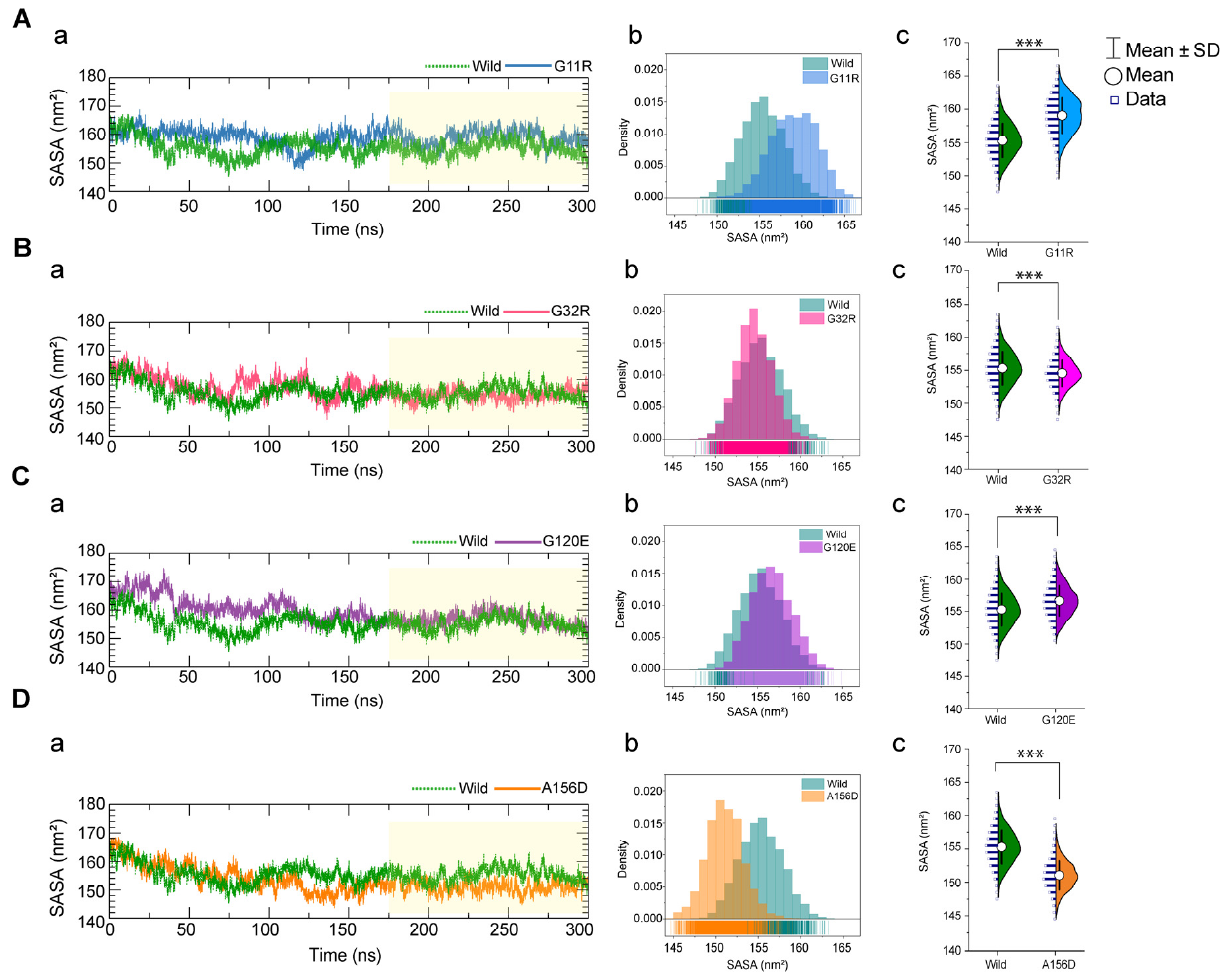
Figure 4. Analysis of total solvent accessible surface area (SASA) of the protein inferring the changes in the NAGK conformational stabilities. SASA value of G11R ( A ), G32R ( B ), G120E ( C ), and A156D ( D ) variants versus wild-type NAGK, where, in all cases, ( a ) represents time-dependent changes during the simulation, while ( b ) and ( c ) describe probability density and mean difference in the SASA distribution, based on the last 125 ns trajectories. The annotations used in A ( c ), B ( c ), C ( c ), and D ( c ) represent statistical significance, denoting *** p < 0.0001. Two-tailed, equal-sample variance Student’s t -tests were used to calculate the p values.